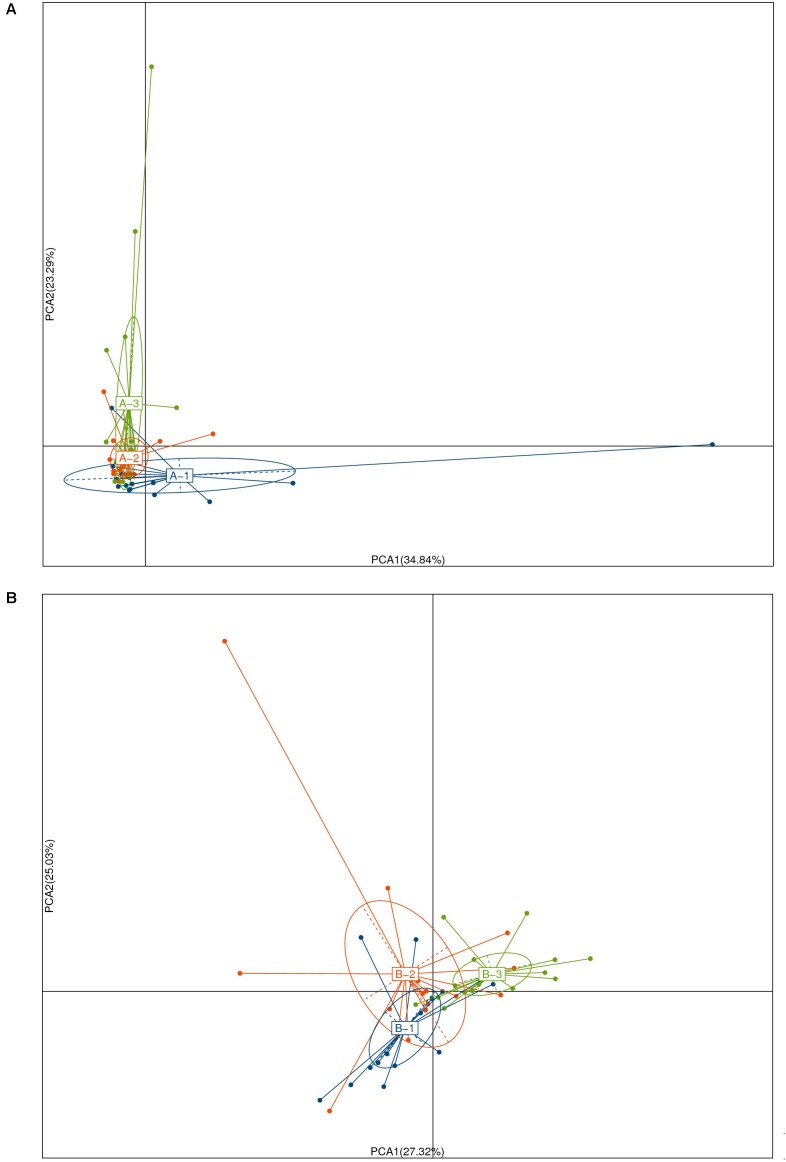
Principal coordinate analysis of unweighted Unifrac community distances for intestinal microbiota of the pre- (A) and post- (B) intervention among NG(1), Bs(2), and Bs(3) groups.